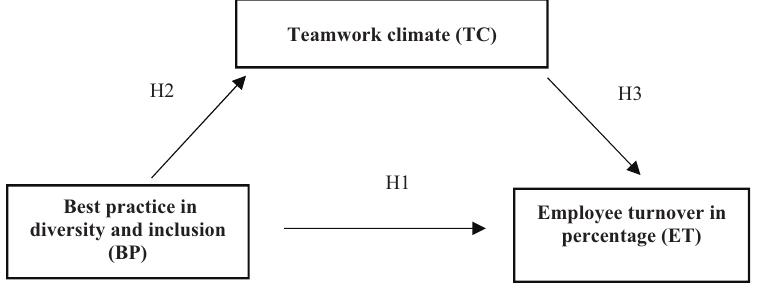
Figure 1. Used mediator model (source: own research) Table 1. Content of analyzed variables Best Practice and Teamwork Climate (source: own research) Best practices in diversity and inclusion in business (BP) (1 – we do not apply at all, 7 – we apply